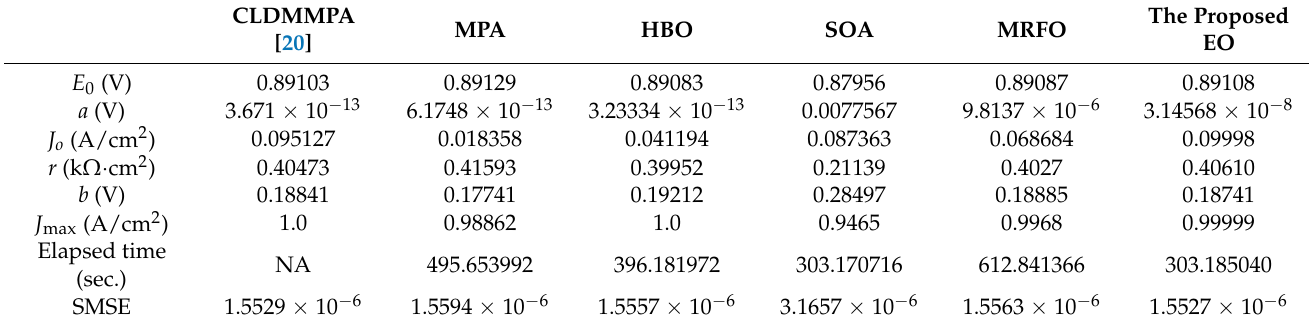
Table 2. The optimal parameters of SOFC steady-state based model operated at 1173 K.